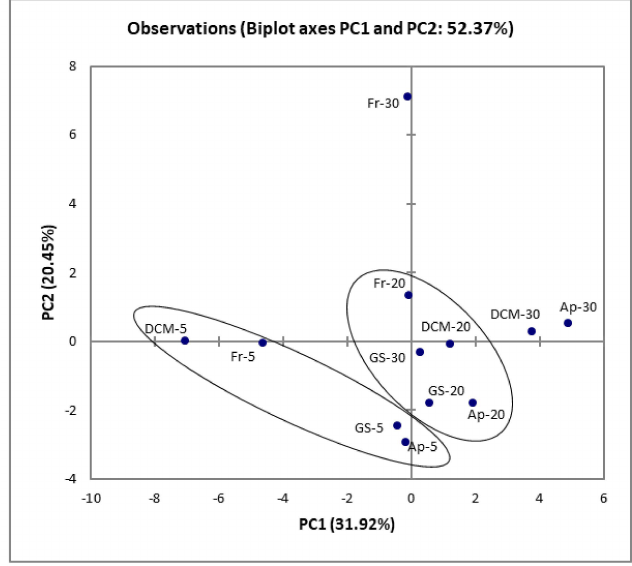
Figure 2. Principal component analysis (PCA) plot of minor volatiles isolated by low alcohol wines fermented by thermally-dried kefir cells. Fr: low alcohol wine fermented by free kefir culture, Ap: low alcohol wine fermented by immobilized kefir culture on apple pieces, DCM: low alcohol wine fermented by immobilized kefir culture on delignified cellulosic material (DCM), GS: low alcohol wine fermented by immobilized kefir culture on grape skins. The fermentation temperature is indicated at the end of the sample